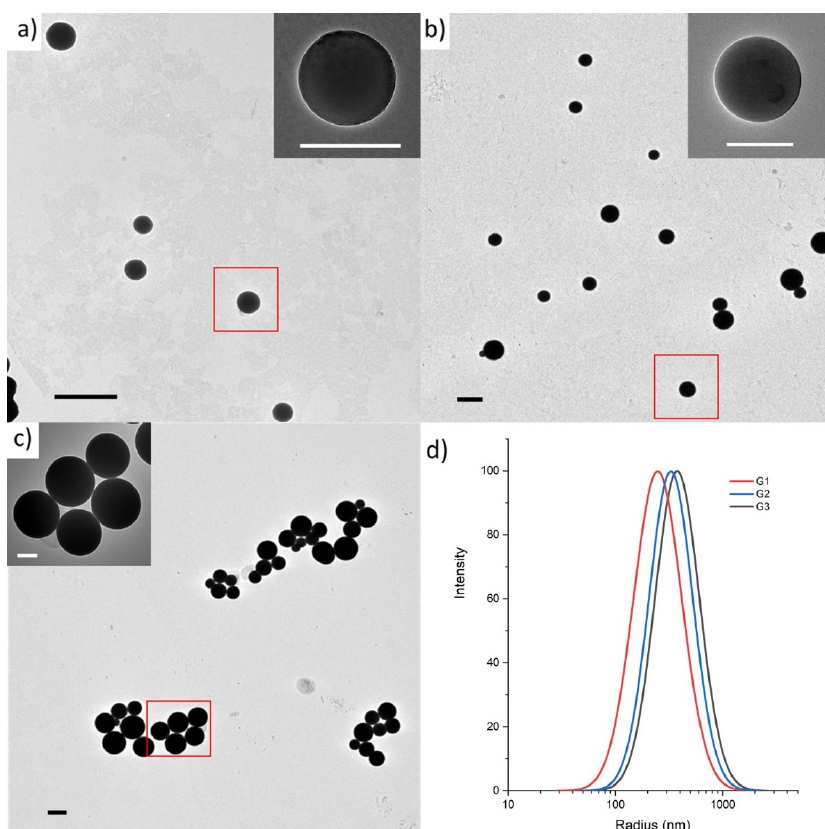
Figure 4. ( a – c ) TEM images of CSNPs from reactions ( a ) G1, ( b ) G2, and ( c ) G3. ( d ) Size distribution of CSNPs determined via DLS. Scale bars for low magnification images for a, b, and c are 1 µm. Scale bars for red box images for a, b, and c are 0.5 µm.